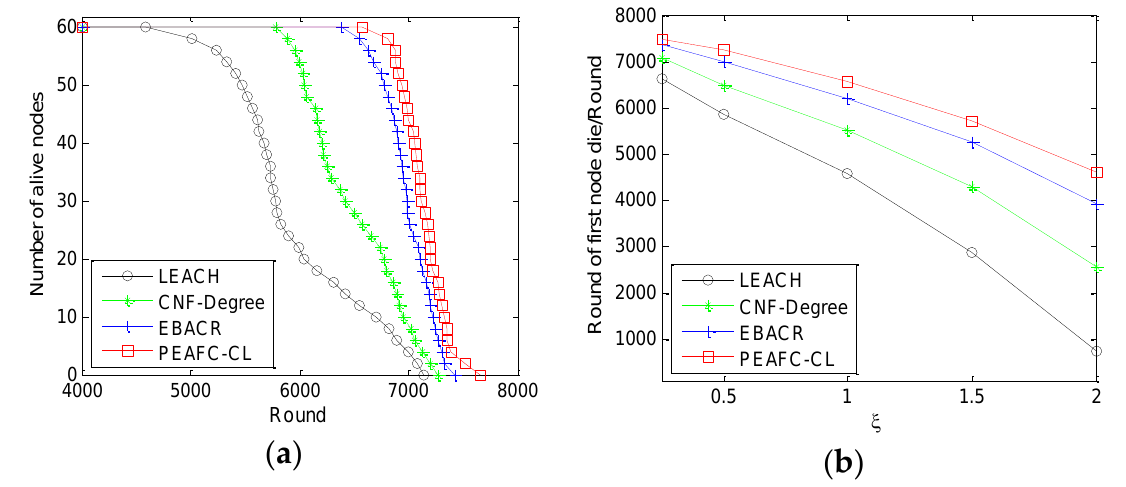
Figure 10. ( a ) Number of nodes still alive vs. the number of rounds; ( b ) Round when the first node dies vs. .